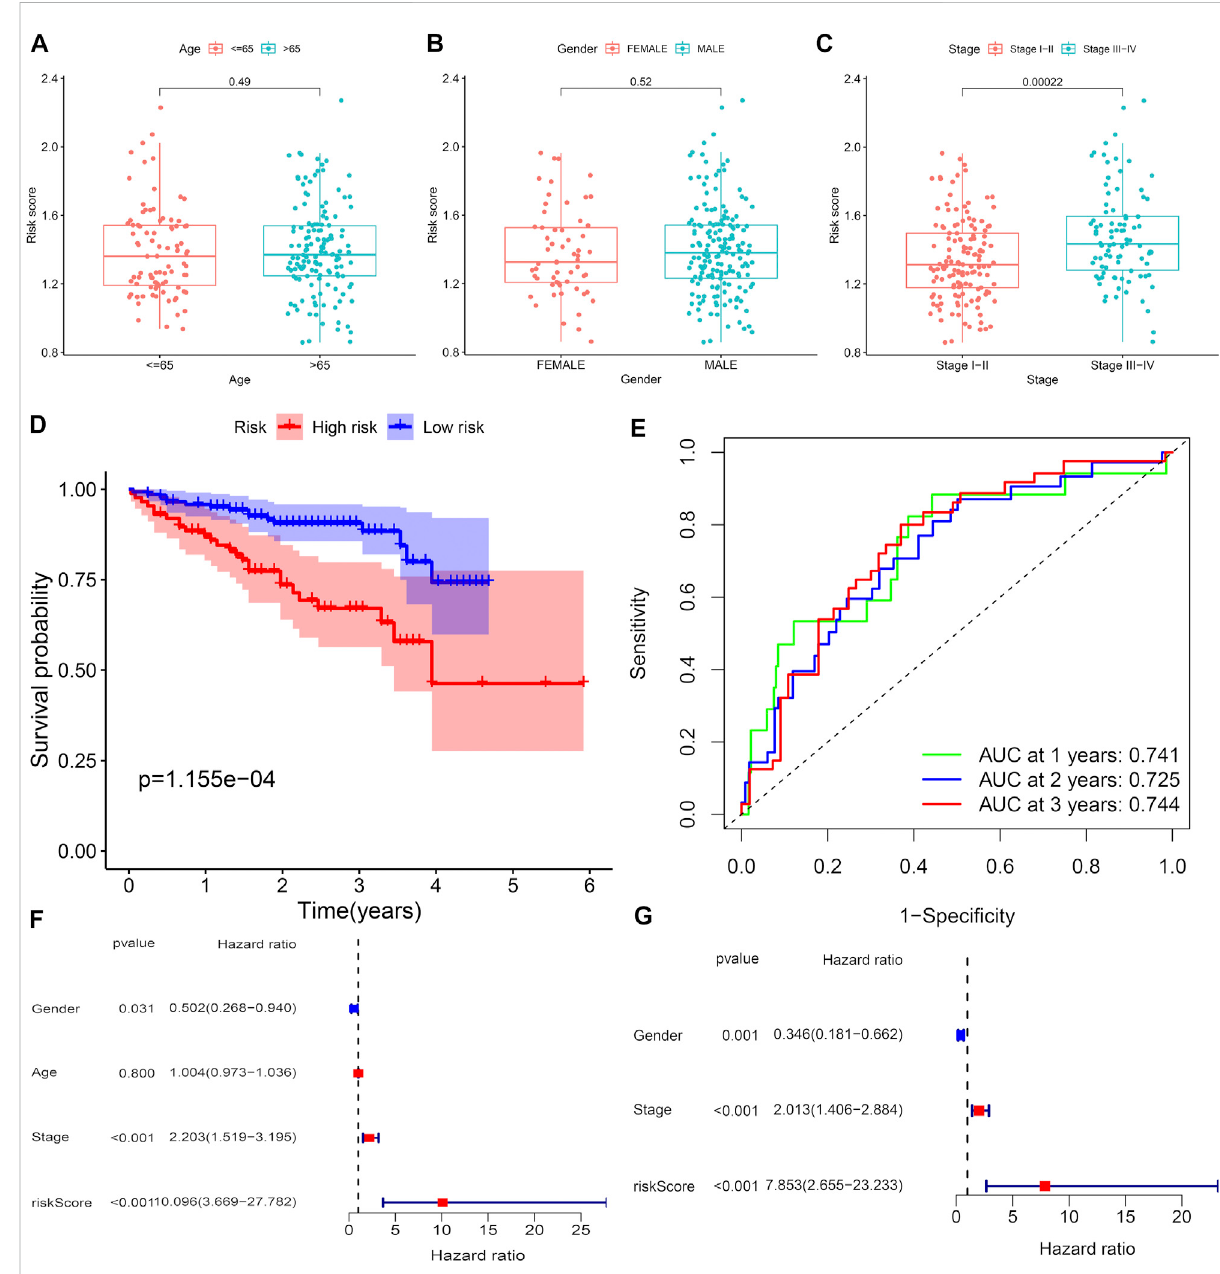
FIGURE 4 Predictive value of CRs scoring model for the survival status of HCC patients in ICGC queue. (A – C) The relationship between risk score and clinicopathological factors, including age (A) , gender (B) , and pathological stage (C) . (D) Comparison of total survival time (OS) in low-risk and high- risk groups. (E) Sensitivity and speci fi city of risk scores measured by ROC curves for predicting 1-, 3-, and 5-year overall survival. (F and G) Forest diagram of univariate and multivariate Cox regression